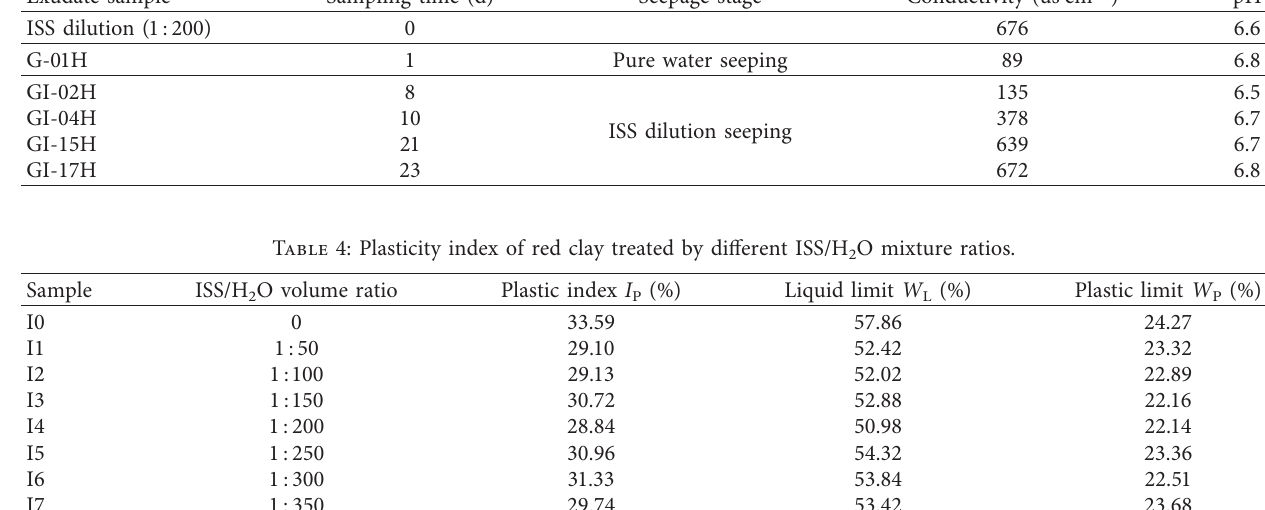
Table 3: The measured electrical conductivity and pH value by collecting the exudate solution.